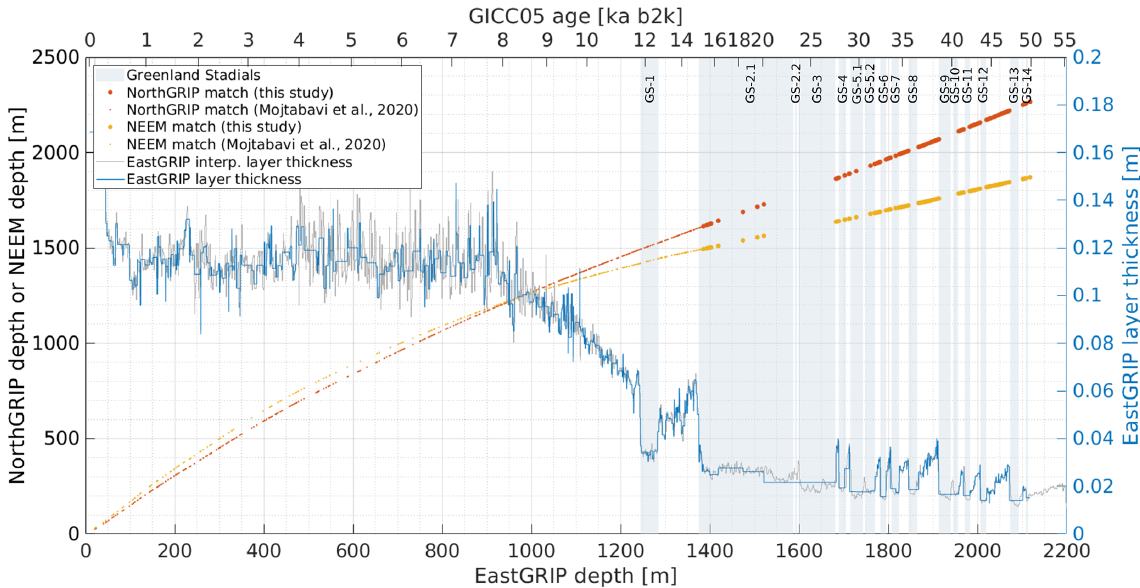
Figure 3. Synchronization between the EastGRIP, NorthGRIP and NEEM ice cores and comparison of match points obtained in this study with earlier results from Mojtabavi et al. (2020). The annual layer thickness of EastGRIP was computed after transferring GICC05 ages by linear interpolation to the EastGRIP ice core. The blue curve shows the annual layer thickness obtained by the match points only. The grey line indicates a high-resolution estimate of annual layer thicknesses at EastGRIP, obtained from the linear interpolation between the EastGRIP–NorthGRIP match points and assigning the interpolated EastGRIP depths to the NorthGRIP